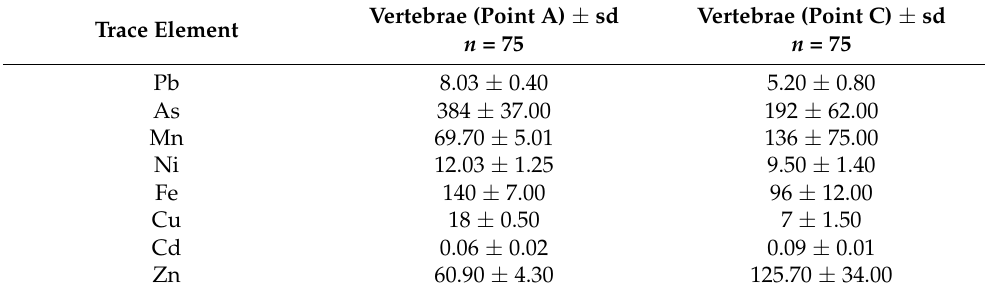
Table 4. Trace element concentrations ( µ g/g) at point A and C of the vertebrae expressed as mean ± sd.